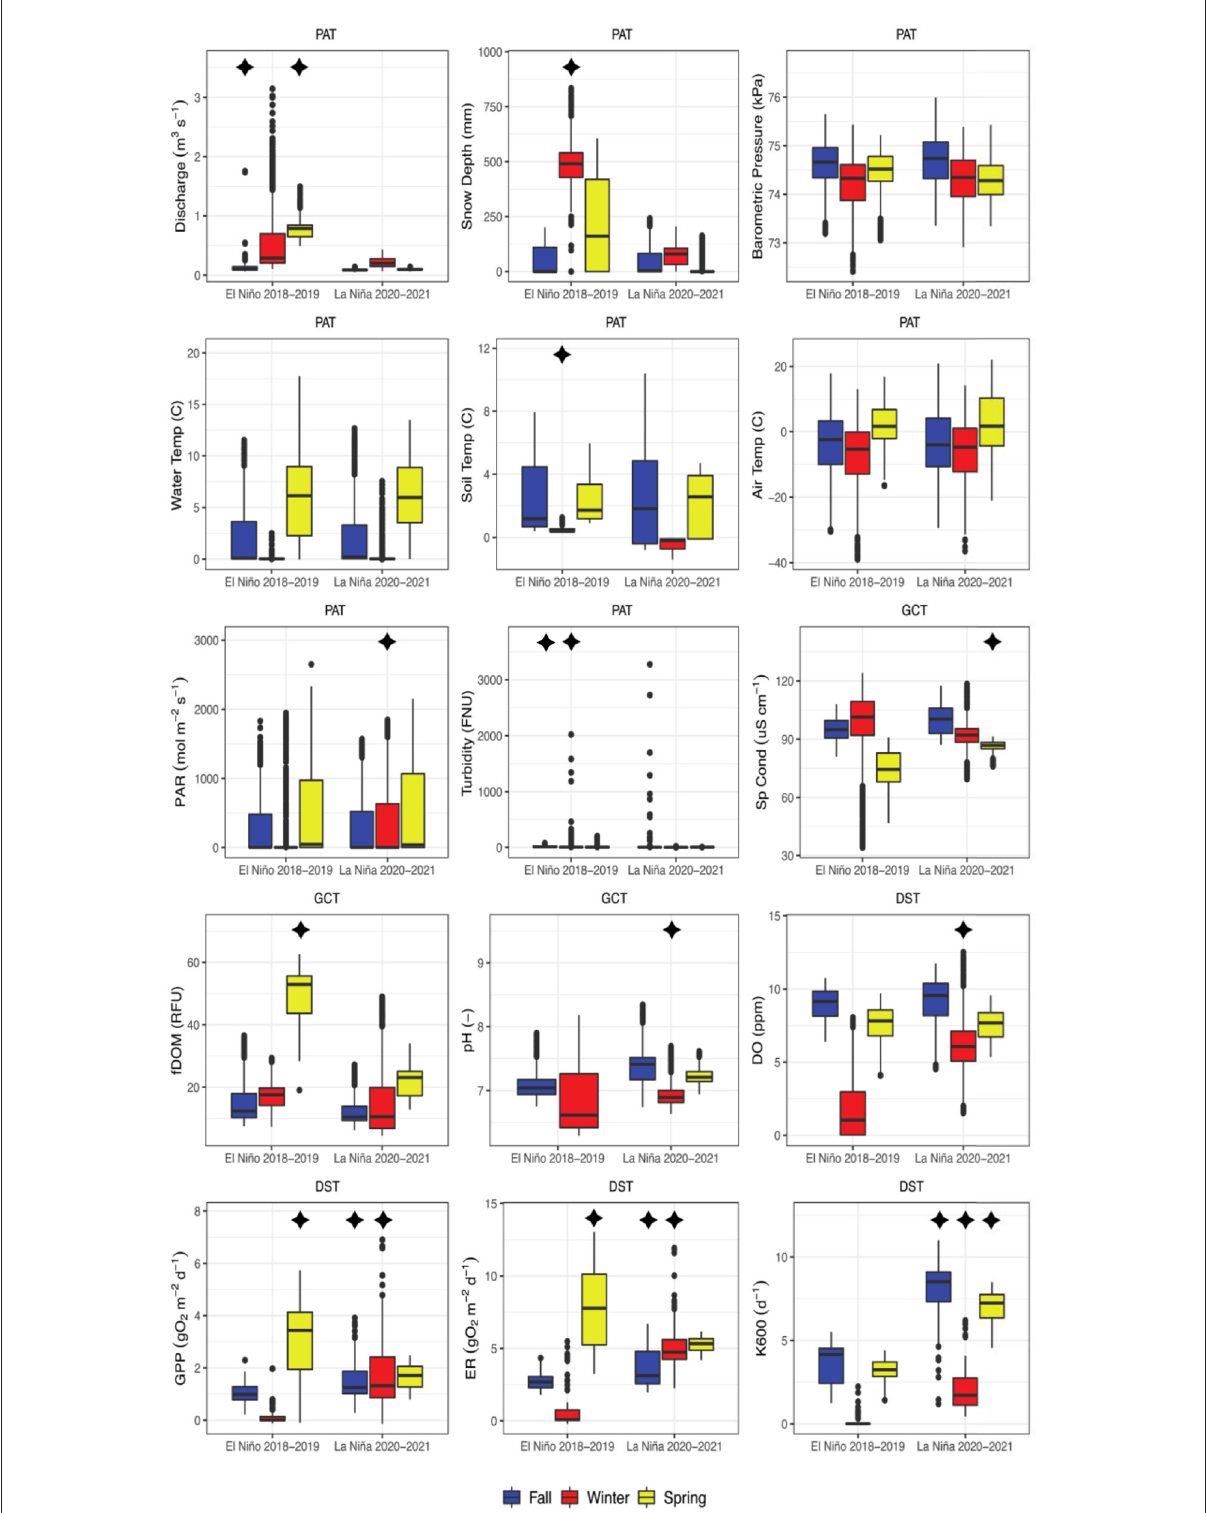
FIGURE3 Boxplots comparing seasonal trends between the 2018–2019 El Niño and the 2020–2021 La Niña years. Asterisks represent quantities with statistically different means for the same season between years, and their location indicate which of the 2 years had a greater mean magnitude. Labels represent the physical and atmospheric (PAT), geochemical (GCT), and DO and stream metabolism (DST)